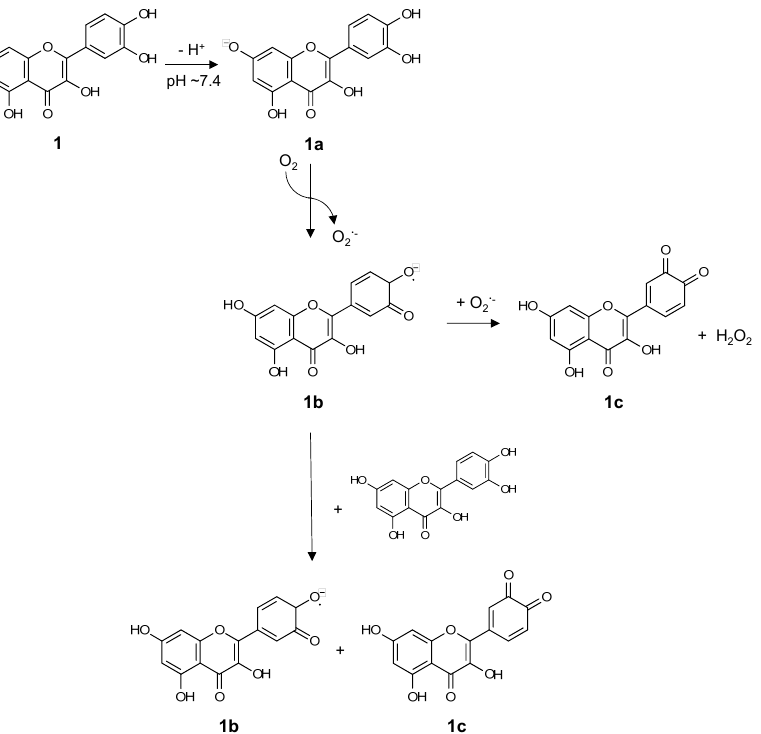
Figure 3. A proposed general auto-oxidative mechanism for flavonoids using quercetin as a repre- sentative structure.